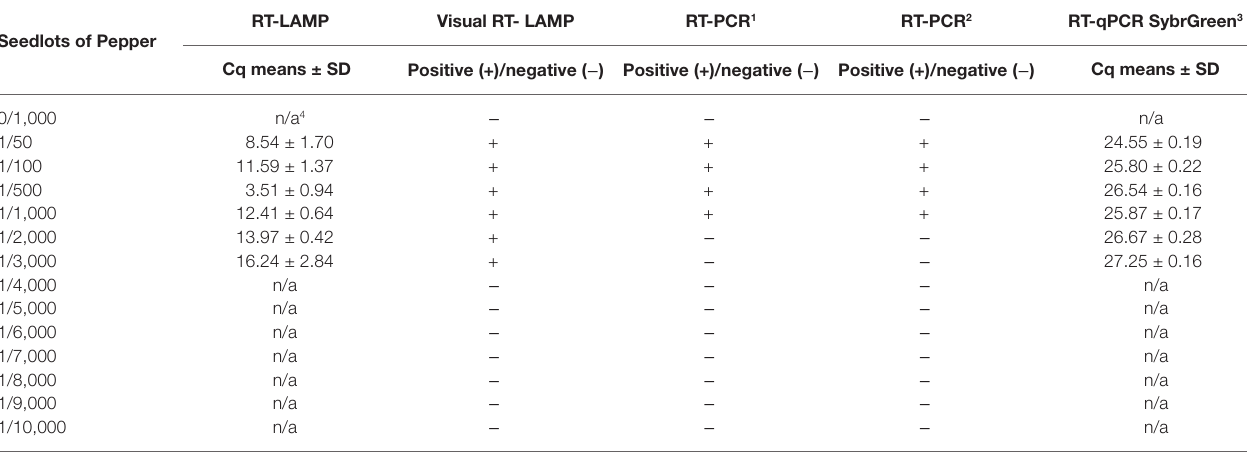
TABLE 5 | Detection of ToBRFV in seed-lots of pepper with different techniques.